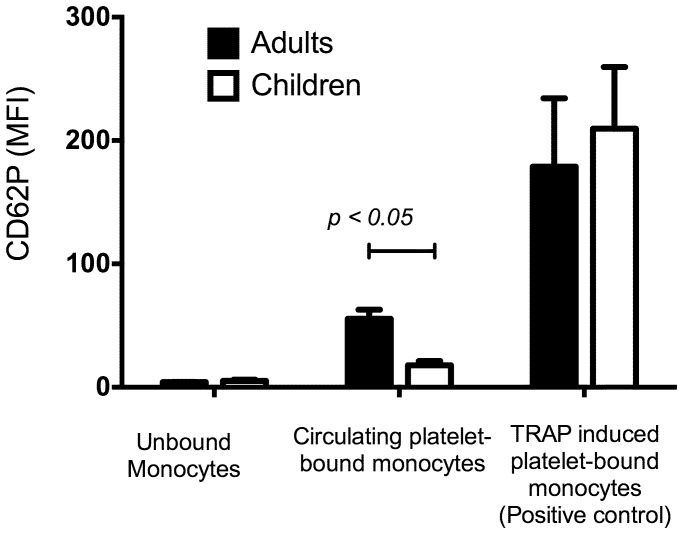
Expression of P-selectin (CD62P) mean fluorescence intensity (MFI) of monocytes with and without platelets bound, with and without the chemical platelet agonist TRAP-6 (positive control) in children and adults.Circulating MPAs in children had lower P-selectin expression than adults, but could be induced to express P-selectin by chemical stimulation. Data shown are mean MFI +/− SEM (adults n = 4 and children n = 4).